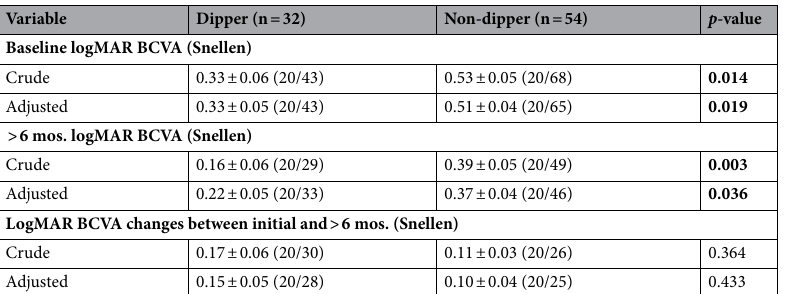
Table 3. Multivariate linear regression analysis of visual acuity between the dipper and non-dipper groups of patients with branch retinal vein occlusion. The non-dipper group showed significantly worse visual outcomes when compared to the dipper group. Night to day systolic blood pressure ratio (%) = (Daytime sysBP − Nighttime sysBP)/Daytime sysBP × 100. Dipper ≥ 10%; Non-dipper < 10%. Statistically significant values appear in boldface. Adjusted for variables in basic and clinical parameters associated with visual acuity (age, sex, body mass index, current smoking status, and alcohol drinking status). BCVA best-corrected visual acuity, logMAR logarithm of minimum angle resolution.